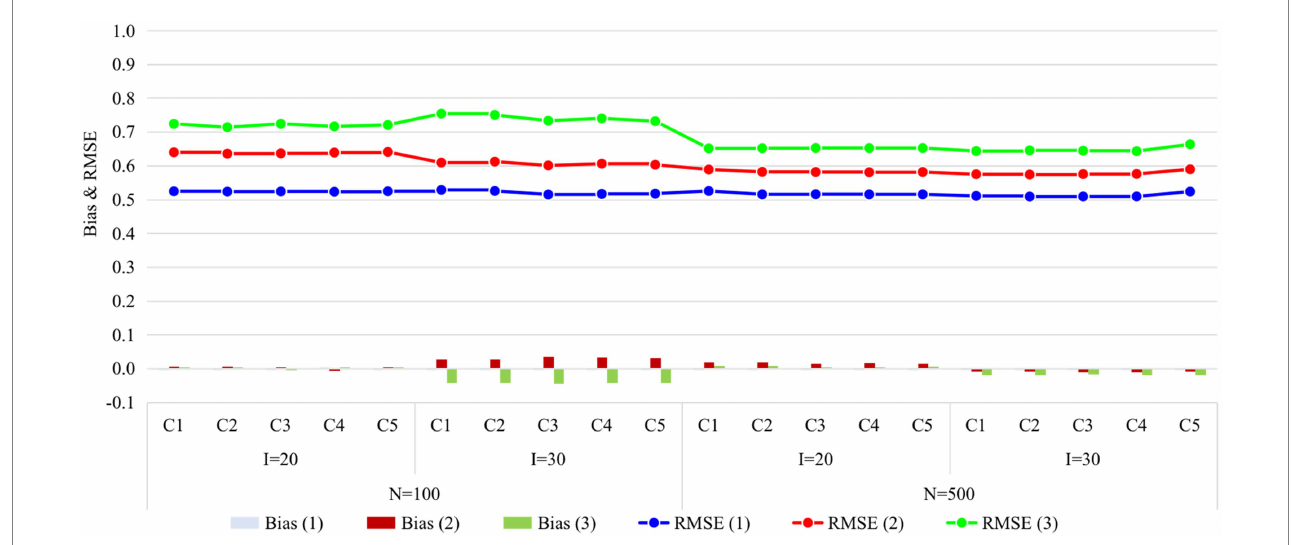
FIGURE 5 Recovery of ability in Study 2. I, number of items; N, sample size; Occasion is in parentheses; C1, ratio of anchor items is 0%; C2, ratio of anchor items is 20%; C3, ratio of anchor items is 40%; C4, ratio of anchor items is 60%; C5, ratio of anchor items is 80%; RMSE, root mean square